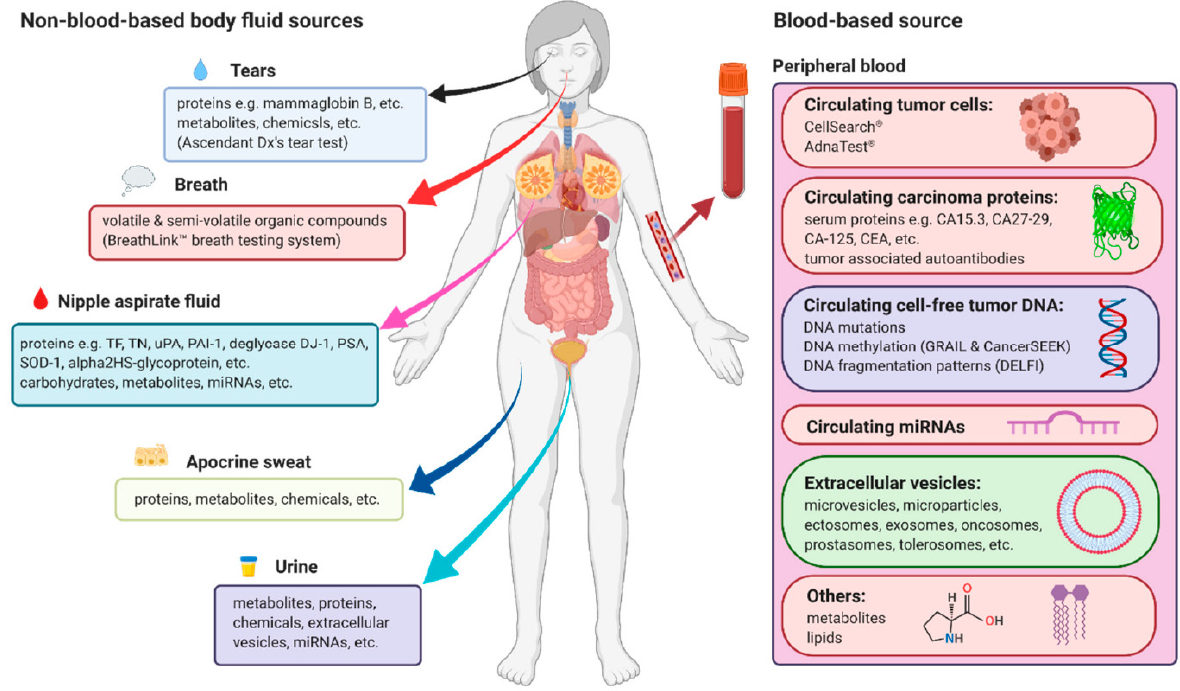
Figure 3. Non-invasive sampling of biomarkers that can be used for early detection of breast cancer in human samples. Adapted with permission from [68]. 2020, MDPI